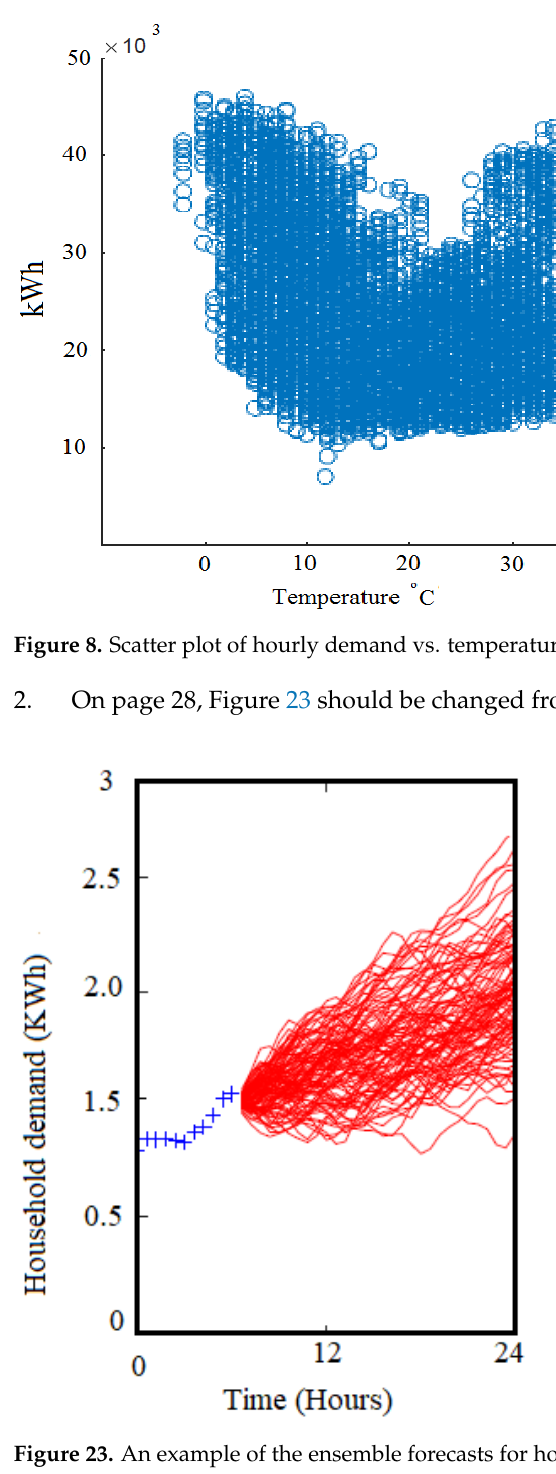
Figure 23. An example of the ensemble forecasts for household demand.